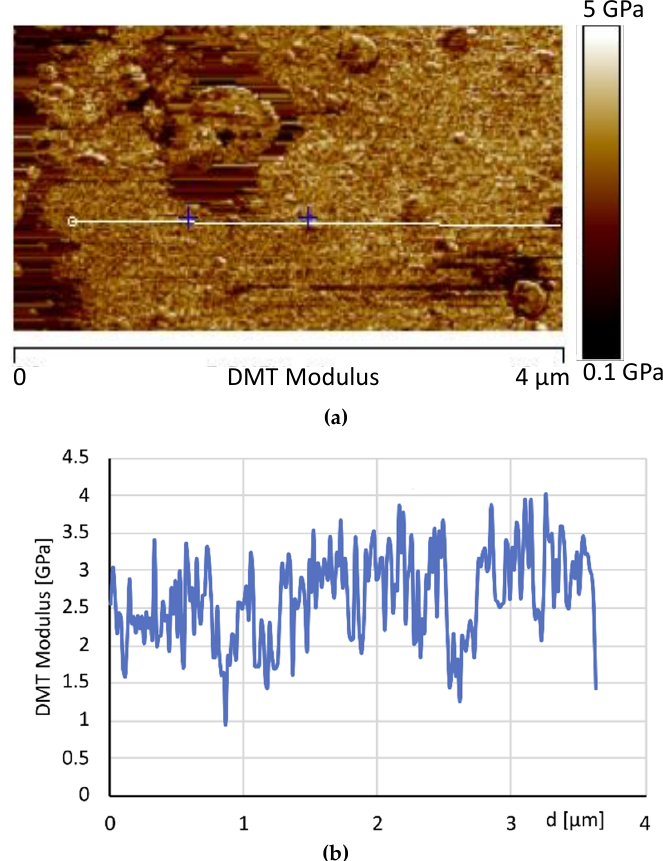
Figure 17. ( a ) AFM image of the DMT modulus maps with the profile ( b ) of the value of the elastic modulus (elastic modulus scale of the sample taken along the white line) of the same